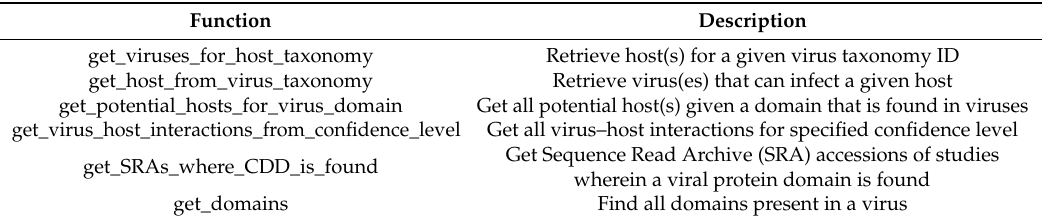
Table 2. Summary and description of primary viral-index API query functions.